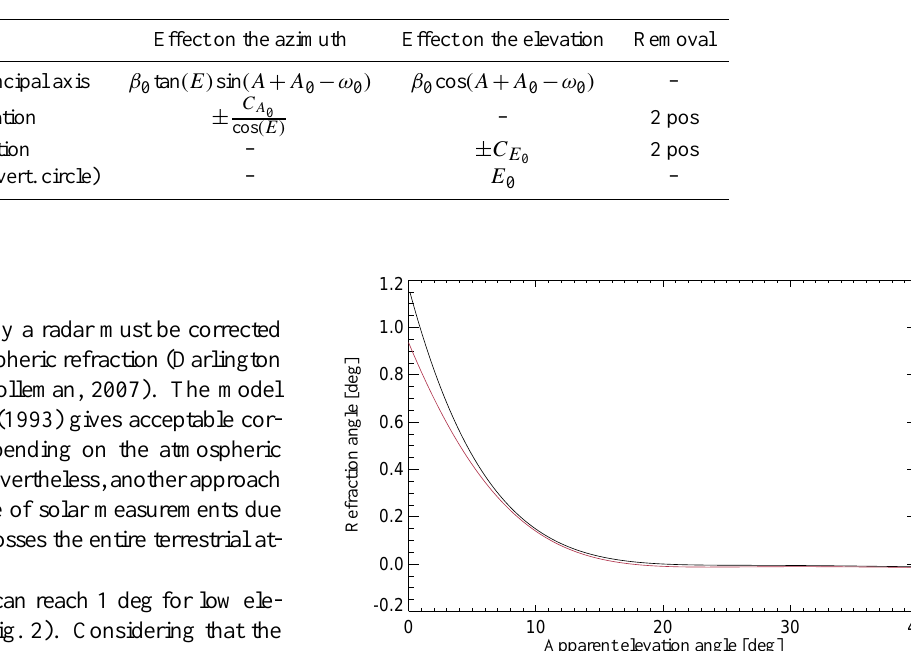
Fig. 1. Main instrumental errors: inclination of the principal axis ( β 0 , ω 0 ), collimation errors ( C A and the index default affecting the elevation angle ( E 0 ). The antenna drawing has been kindly provided by Prosensing Inc.